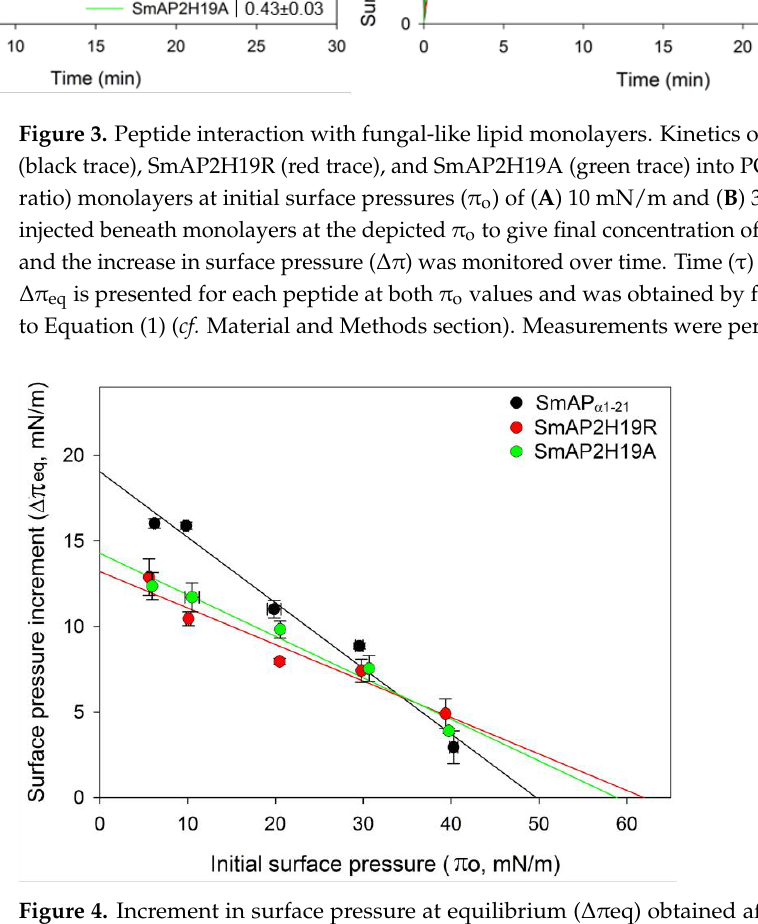
Figure 5. ( A ) Bright field (bottom) and fluorescence (above) images of Fusarium graminearum conidia incubated with peptides SmAP2H19R and SmAP2H19A at their MIC for 1 h. Cetrimide